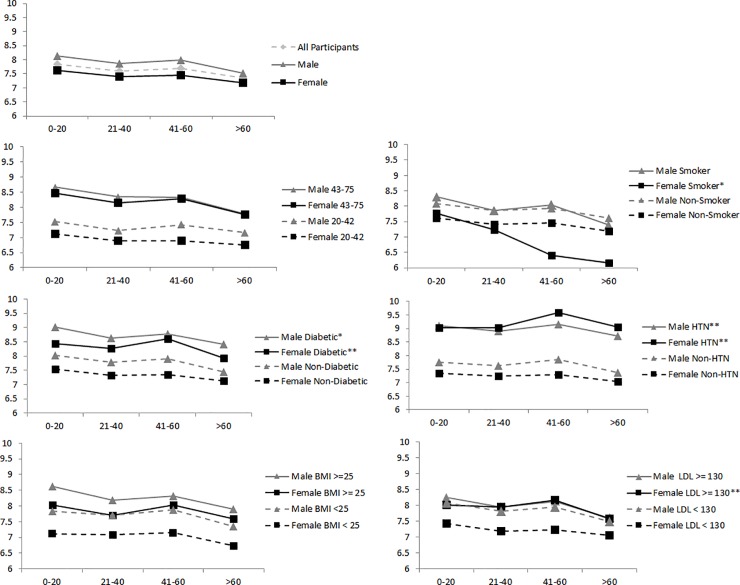
Mean unadjusted carotid-femoral pulse wave velocity (m/s) by 20 km distance intervals stratified by cardiovascular disease risk factors and sex.Lines with lighter symbols and triangle markers represent males and lines with darker symbols and square markers represent females. Solid lines represent groups that have higher levels of cardiovascular disease risk factors (e.g., older, smokers, or higher body mass index) while dashed lines represent groups that have lower levels of cardiovascular disease risk factors. HTN = hypertension; BMI = body mass index; LDL = low density lipoprotein. All tests for trends have p < 0.001 except those indicated by * (p < 0.05 but ≥ 0.001) or ** (p > 0.05).